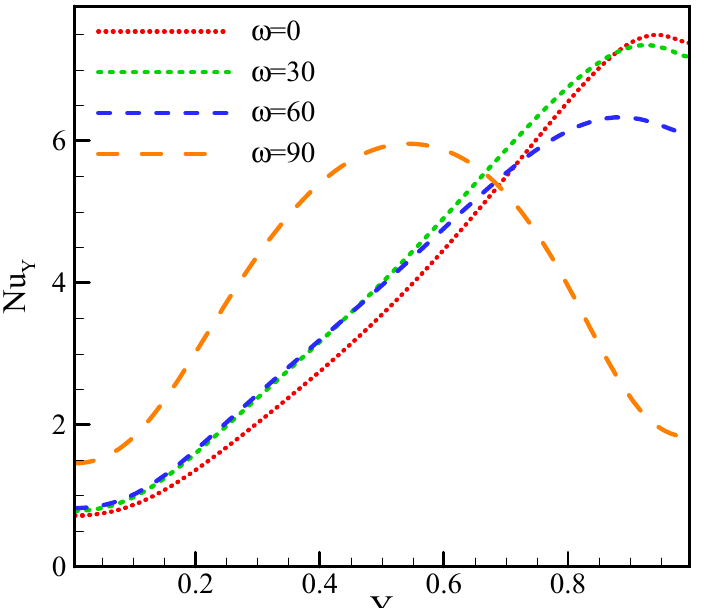
Figure 13. Local Nu for Ra = 10 5 , Rd = 1, Ha = 20, AR = 0.45 − 0.6, γ = 45, ϕ = 0.03, and different cavity angles.